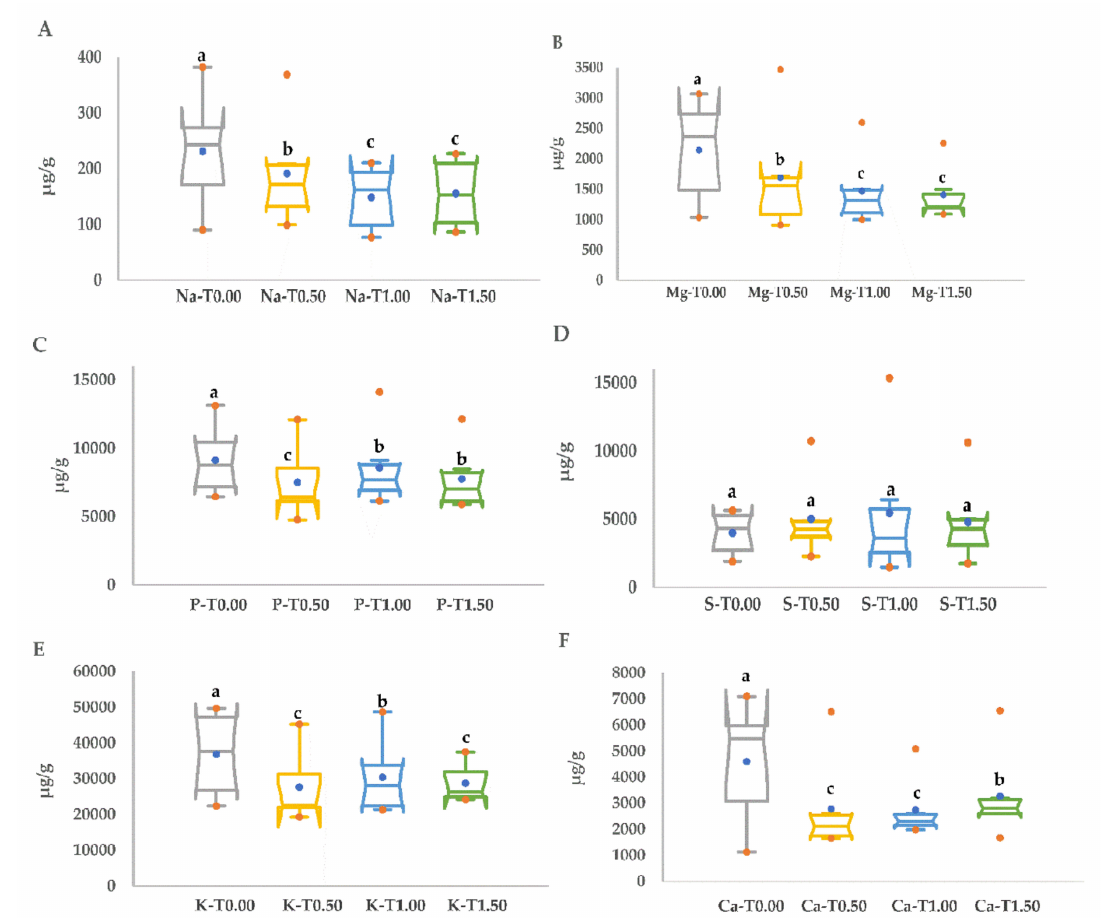
Figure 4. Box charts of inorganic elements of the kernel-derived calli from six rice genotypes, indicating wide di ff erences between control and stress conditions. ( A ): Na, ( B ): Mg, ( C ): P, ( D ): S, ( E ): K, and ( F ): Ca. The numbers given are the mean values determined for the six measurements obtained for control (T0.00), and PEG concentrations (T0.5, T1.00, and T1.50). The di ff erent letters indicate a significant variation between the mean values of each trait by Duncan’s multiple-range analysis ( p ≤ 0.05). A blue dot in the box represents the mean value. Red dots denote the minimum and maximum values, while extreme values (outliers) are shown as dots outside the